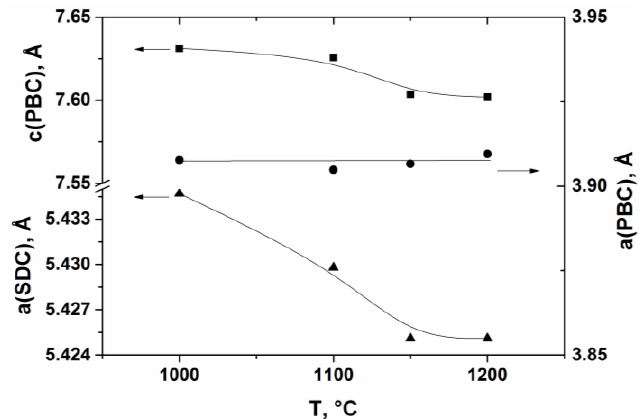
Figure 4. PBC and SDC cell parameter versus calcination (for 12 h in air) temperature. Lines are guide to eye only.